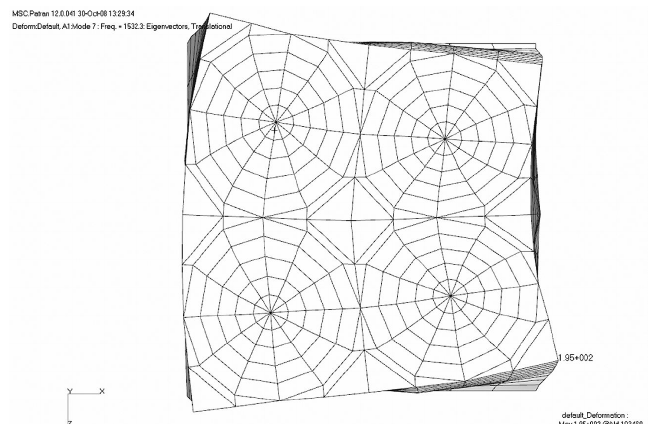
Fig. 20. 7th mode: 1532